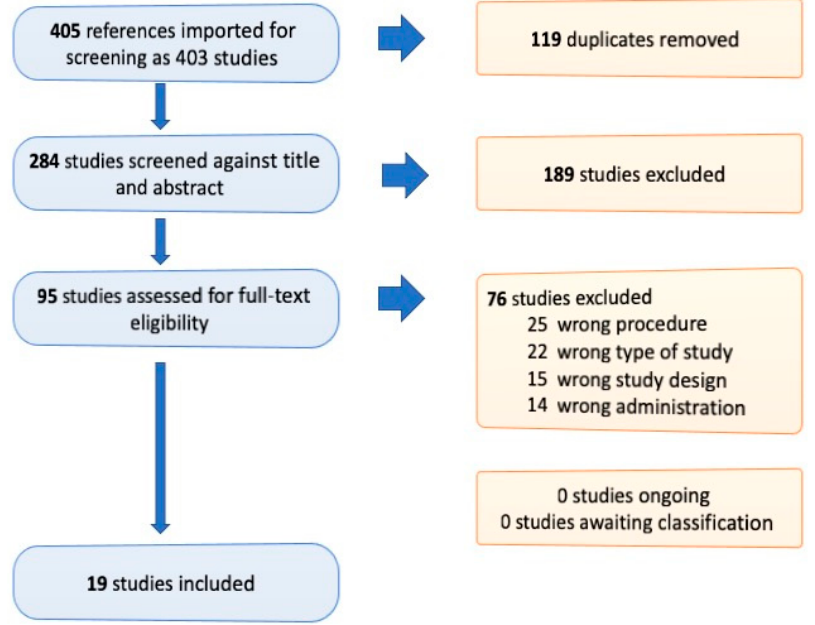
Figure 1. PRISMA Flow diagrame showing the selection of articles. Table 1. Results of articles using CO 2 laser technology.